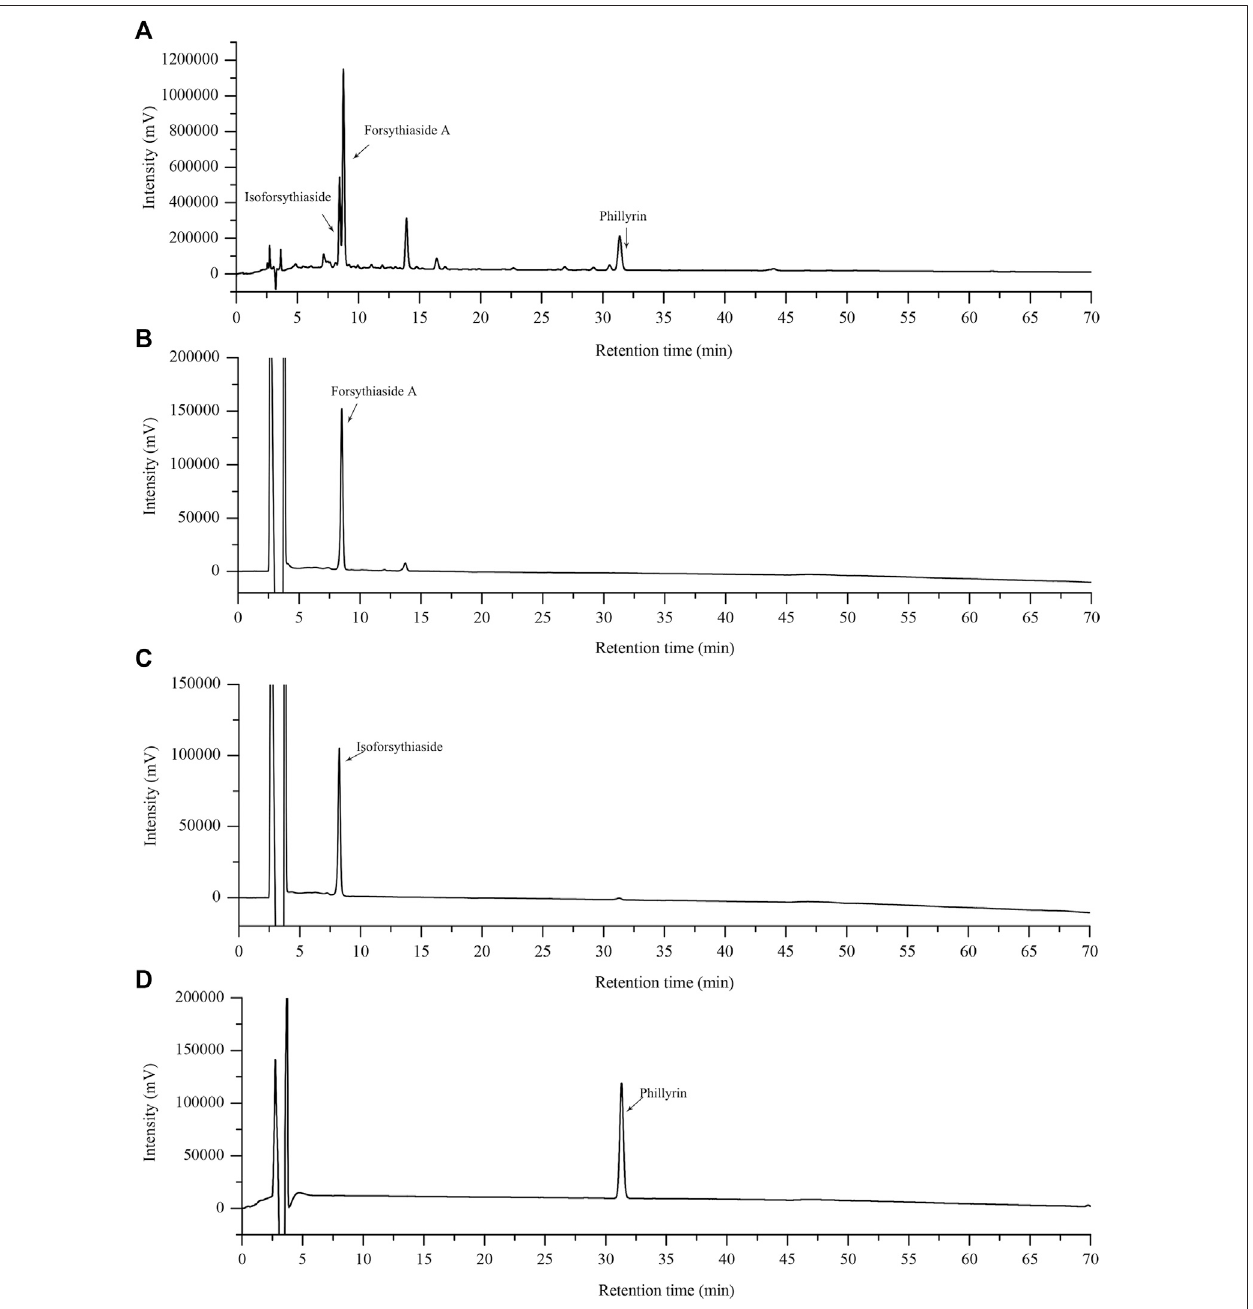
FIGURE 1 | HPLC chromatograms of FRE and its characteristic components. The fi ngerprint of FRE (A) and the chromatograms of three marker components, forsythiaside A (B) , isoforsythiaside (C) , and phillyrin (D) , respectively.